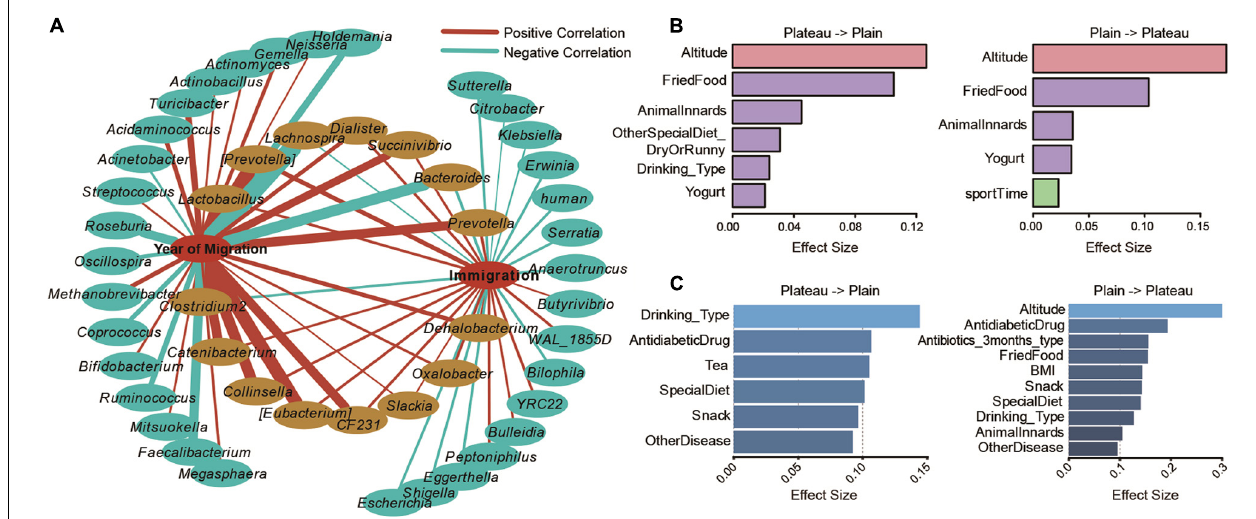
FIGURE 4 | Altitude migration affects the diversity of the Tibetan gut microbiome. (A) Correlation network of genera significantly correlated with the year of migration or the generation of immigration (adjusted P < 0.05). Factors significantly contributed to diversification of Chao1 index (B) and taxonomic composition (C) were also